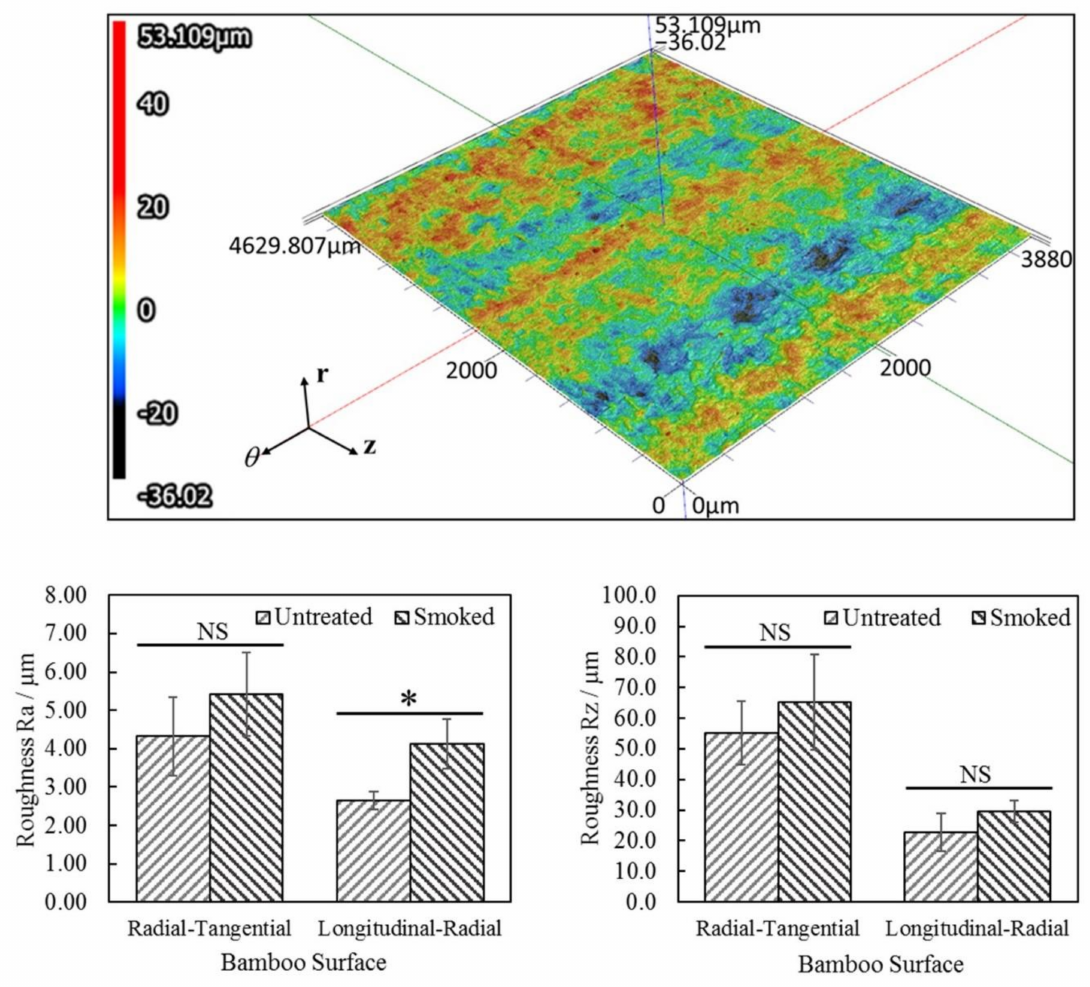
Figure 7. ( a ) 3D map of longitudinal-radial surface of smoked bamboo with a height magnification of 100% and ( b ) comparative study of mean roughness parameter Ra and ( c ) of the average maximum peak to depth parameter Rz (* statistically significant difference, NS = no significant